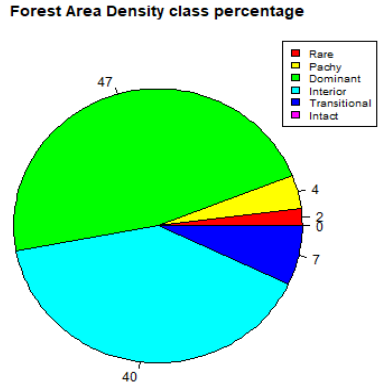
Figure 5. Forest Area Density (FAD) showing percentage of fragmentation class